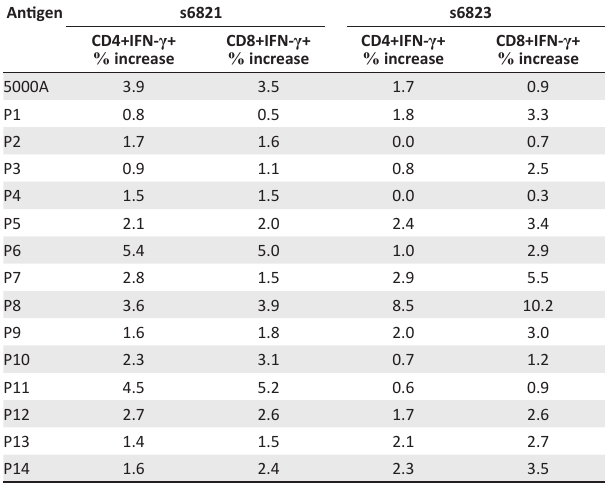
TABLE 6: Percentage of CD4+ and CD8+ T cells producing IFN- γ after in vitro stimulation of peripheral blood mononuclear cells from immune sheep (6821 and 6823) at a concentration of 10 µ g/mL. The % increase was compared to medium. Antigen s6821